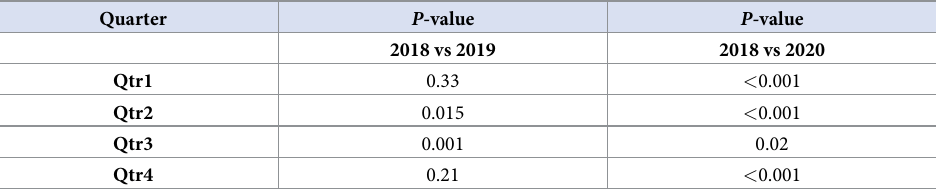
Table 1. 2018 referral data compared to 2019 and